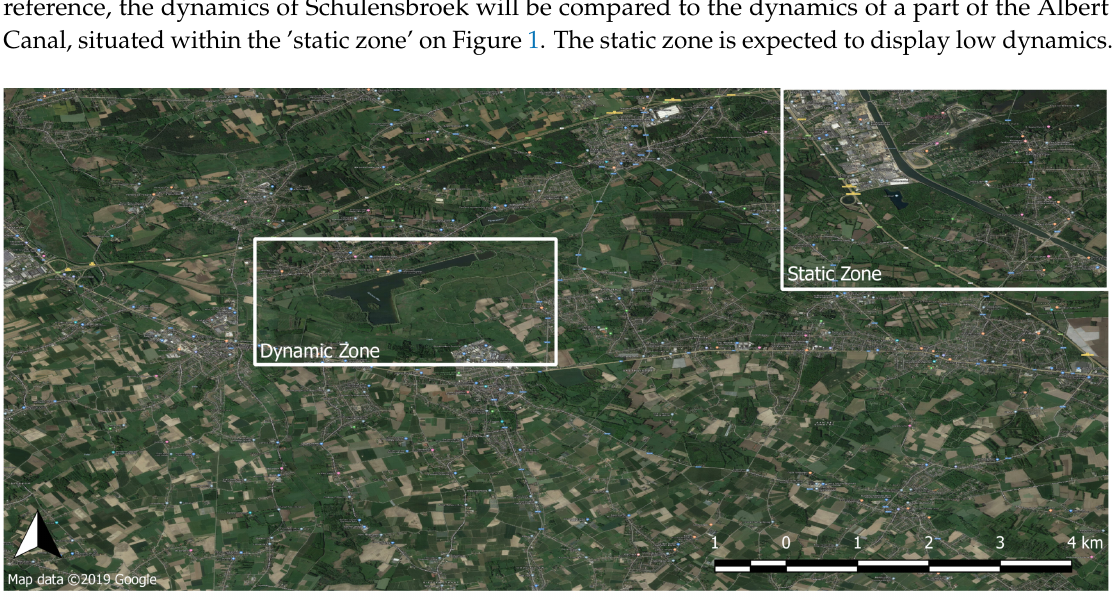
Figure 1. Study area with Schulensbroek nature reserve and its surroundings. Regions of interest: Dynamic Zone and Static